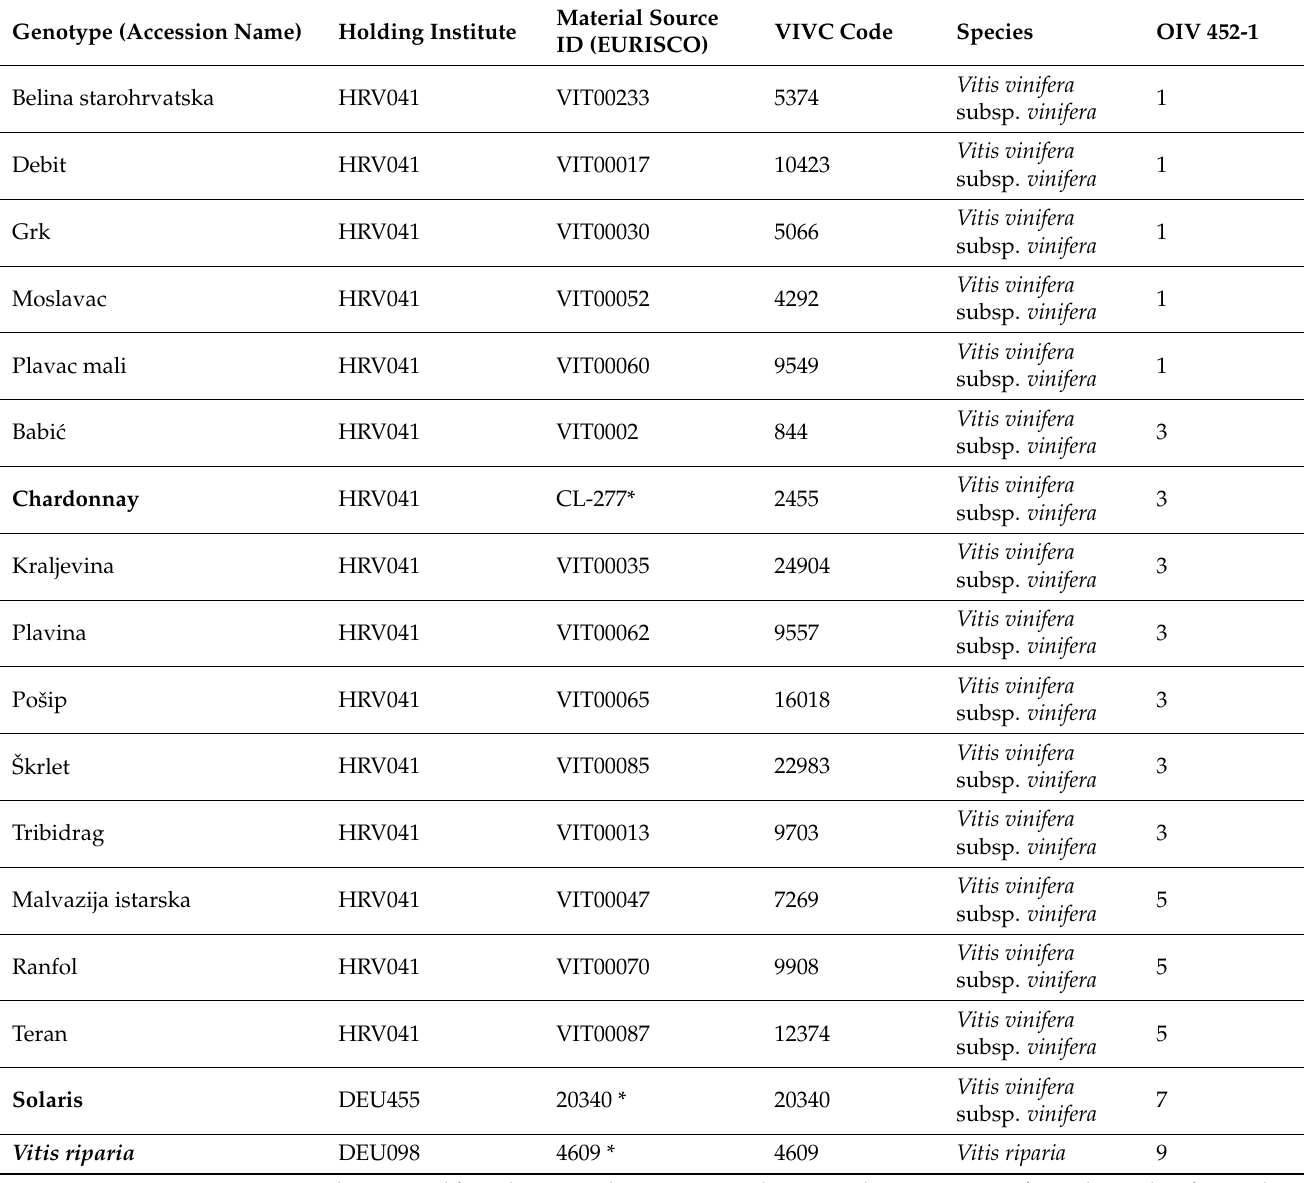
Table 1. Genotypes, additional information on the plant material, and genotypes’ corresponding OIV classes of resistance to P. viticola (OIV 452-1) according to OIV [46]. Genotypes in bold were used as